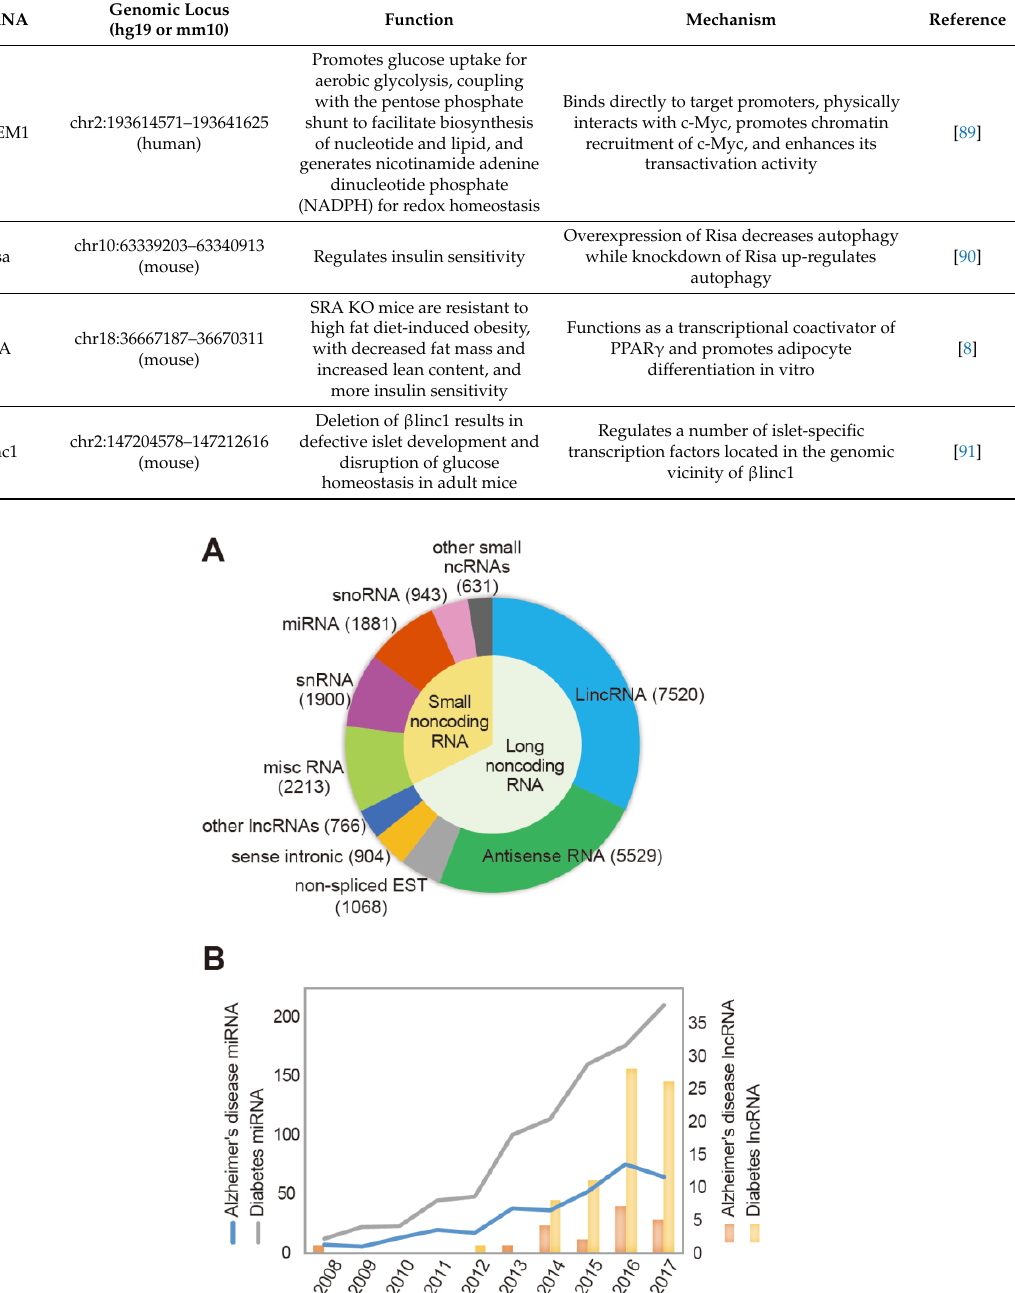
Figure 1. The classification of noncoding RNAs (ncRNAs) and the number of papers published on the study of ncRNAs in Alzheimer’s disease (AD) and diabetes. ( A ) The number of ncRNAs identified in humans. The classification of ncRNAs is based on GENCODE (Version 26, October 2016) [92]. The number of ncRNAs in each group is indicated in parentheses. ( B ) The number of research papers on long ncRNAs (lncRNAs) and microRNAs (miRNAs) in AD and diabetes published in the past 10 years is shown. The papers were located in PubMed and review papers were excluded. Note that although the number of lncRNAs, including long intergenic ncRNAs (lincRNAs), antisense RNAs, and sense intronic RNAs, is larger than that of regulatory small RNAs, only a few papers have been published on lncRNAs in AD and diabetes compared to those published on miRNAs. EST: expressed sequence tag, snRNA: small nuclear RNA, snoRNA: small nucleolar